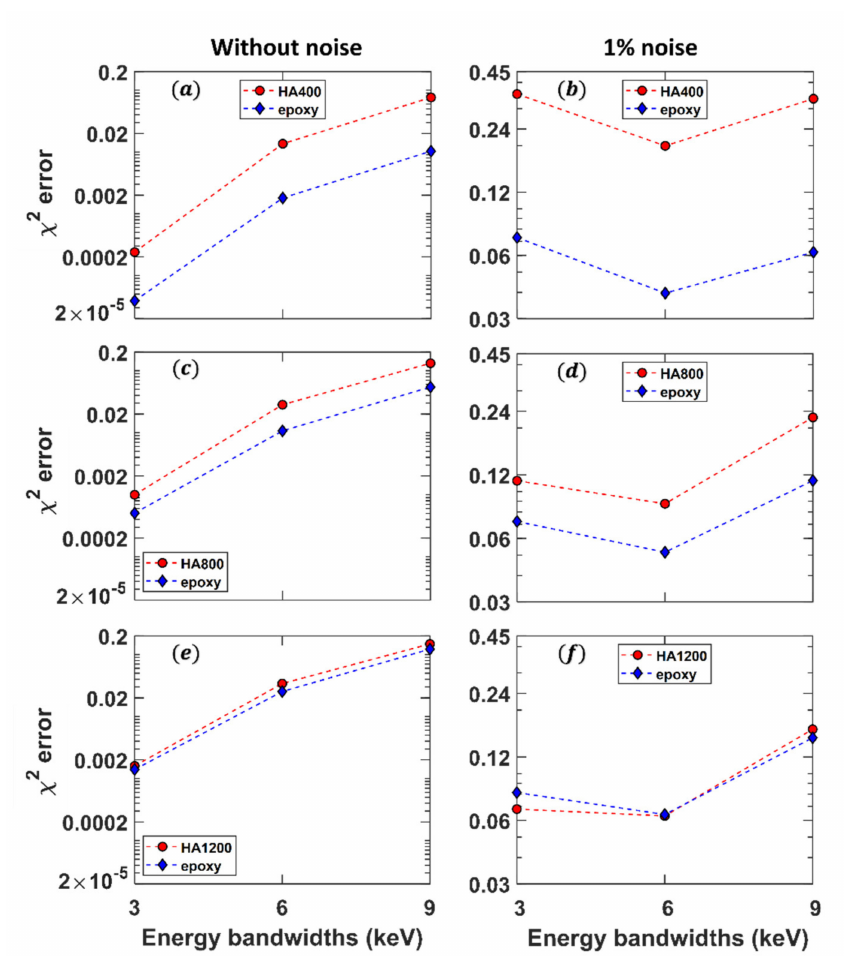
Figure 5. Calculated χ 2 error plots as a function of the energy bandwidth in the absence of noise (left-hand column) and with 1% noise included (right-hand column), showing the separation of ( a , b ) HA400, ( c , d ) HA800, and ( e , f ) HA1200 from the surrounding epoxy